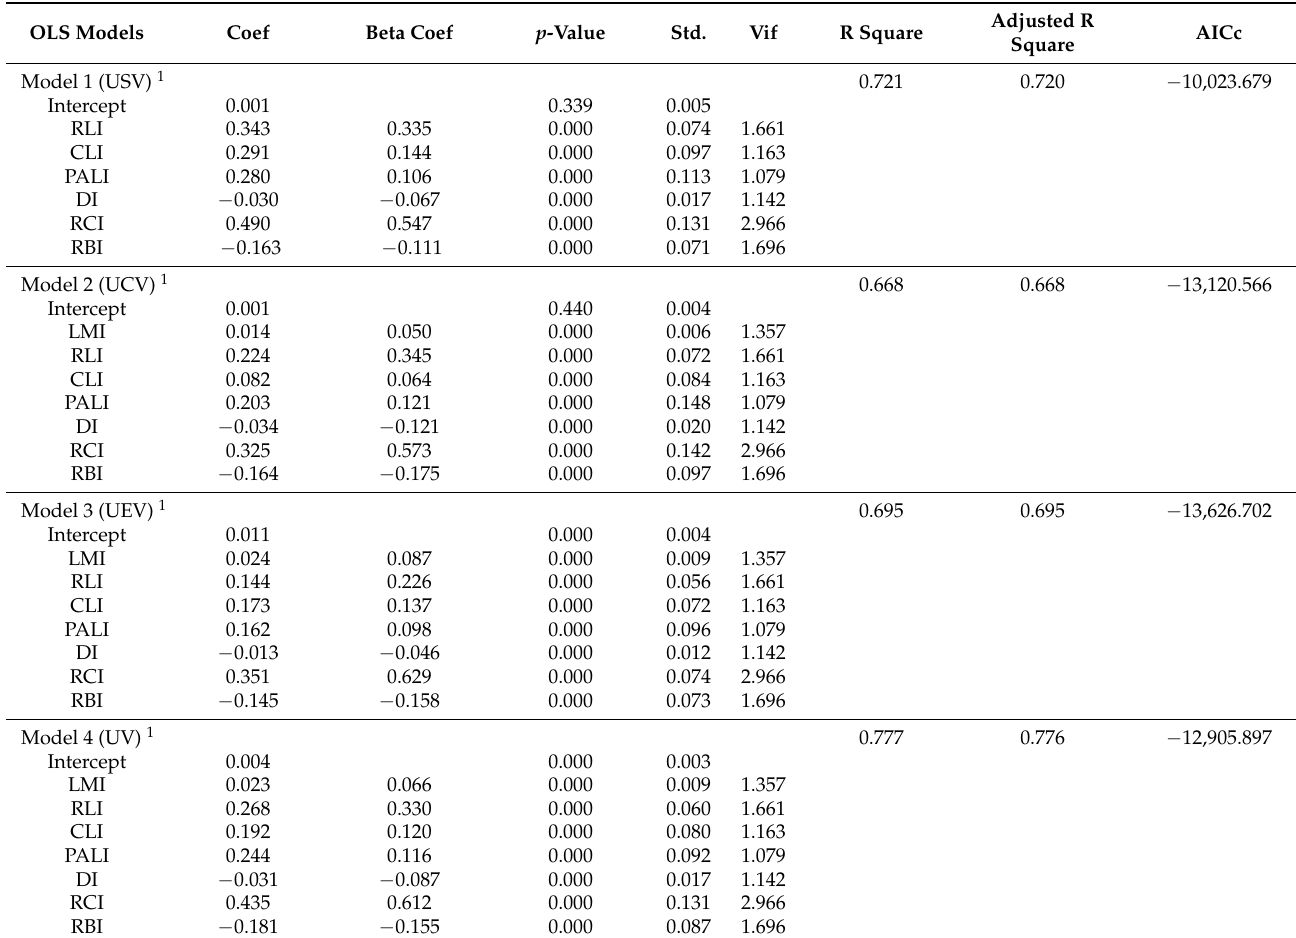
Table 2. The results for ordinary least squares